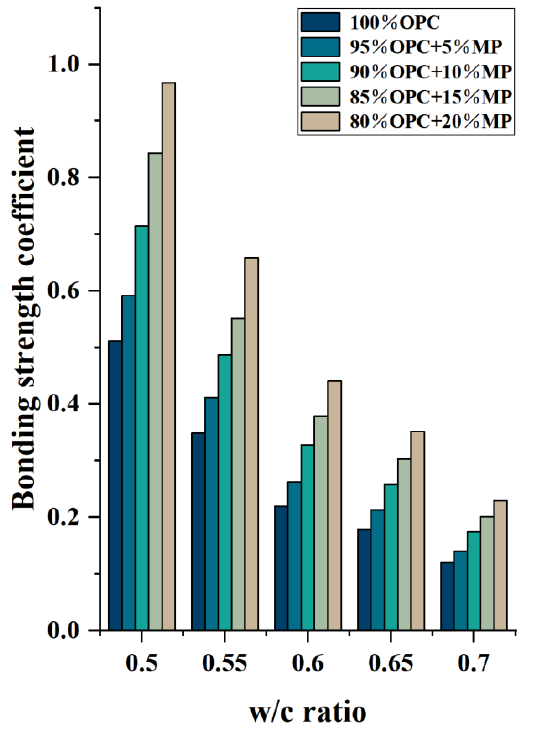
Figure 12. Differentiation of bonding strength coefficient with W/CM at different MP contents. Table 4. Variation of flocculation structure mass fraction with W/CM at different MP contents.